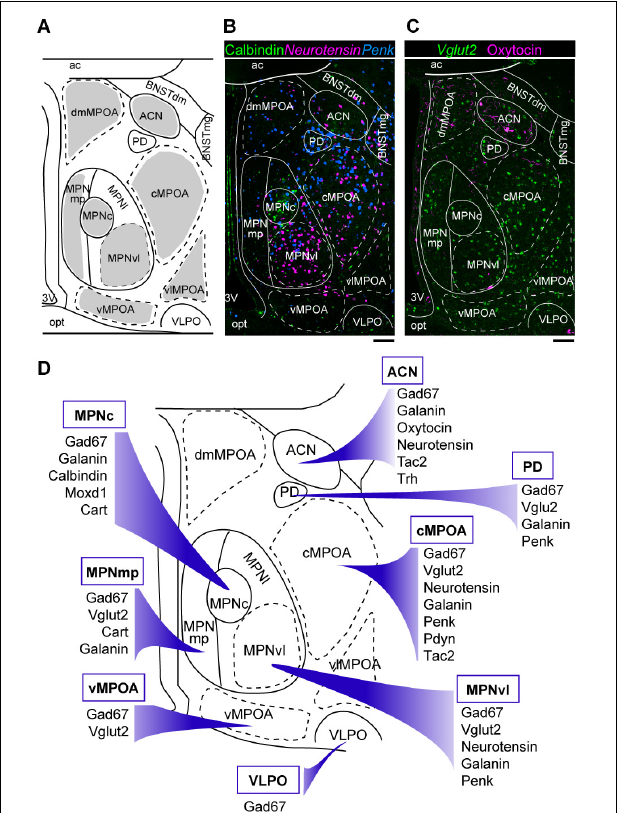
FIGURE 1 | Neuroanatomy and heterogeneity of the medial preoptic area. (A) Coronal mouse brain diagram showing the MPOA subregions at the level of the MPNc (bregma, –0.02 mm). (B) Double ISH for Penk (blue) and neurotensin (magenta) mRNAs with immunostaining for calbindin (green). (C) ISH for Vglut2 (green) mRNA with immunostaining for oxytocin (magenta). (D) Summary of marker genes expression in selected MPOA subregions. Each subregion has a characteristic pattern of marker expression. Scale bars: 100 µ m. 3v, third ventricle; ac, anterior commissure; ACN, anterior commissural nucleus; BNSTdm, dorsomedial nucleus of the BNST; BNSTmg, magnocellular nucleus of the BNST; cMPOA, central part of the MPOA; dmMPOA, dorsomedial part of the MPOA; MPNc, central part of the MPN; MPNl, lateral part of the MPN; MPNmp, posteromedial part of the MPN; MPNvl, ventrolateral part of the MPN; opt, optic tract; PD, posterodorsal preoptic nucleus; vMPOA, ventral part of the MPOA; vlMPOA, ventrolateral part of the MPOA; VLPO, ventrolateral preoptic nucleus. Modified from Tsuneoka et al.